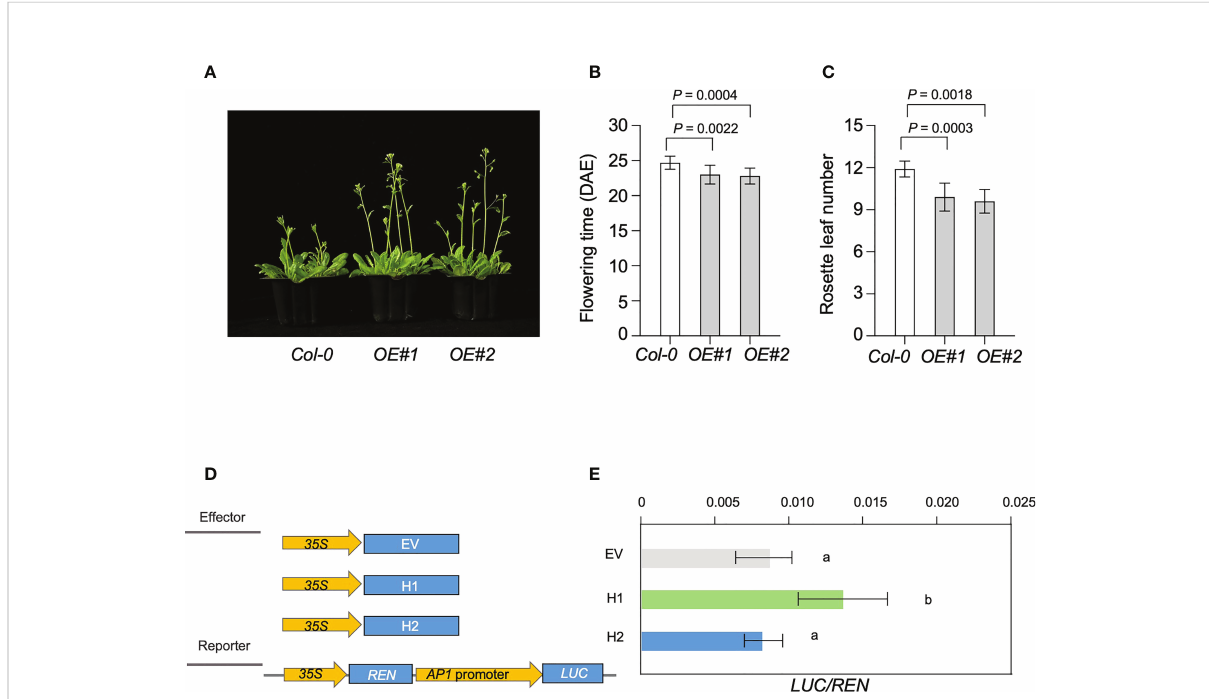
FIGURE 7 Genetic analysis of LJ18. (A) Flowering phenotype of the transgenic plants of Arabidopsis overexpressing LJ18, OE#1 and OE#2 relative to the untransformed control Col-0 plants. (B) Flowering time of Col-0, and LJ18-overexpressing plants under long day (LD) conditions at 22°C. (C) The number of rosette leaves in at least 10 plants at bolting was used as an indicator of fl owering time. Statistically signi fi cant differences are indicated by different lowercase letters (Student ’ s t test, P < 0.05). (D) Schematic maps of the constructs used in the transient expression assay. Empty vector (EV) was used as the negative control. Promoter of AP1a was separately inserted into the vector to get the reporters. 35S, CaMV35S promoter; LUC, fi re fl y luciferase; REN, Renilla luciferase. (E) Transcriptional activity of AP1a promoter reporters in N. benthamina. REN was used as an internal control. LUC/REN represented the transcriptional activity of AP1a promoter. Data represent mean ± SD of three biological replicates. Different lowercase letters represent signi fi cant differences at the level of P < 0.05, based on the Student ’ s t